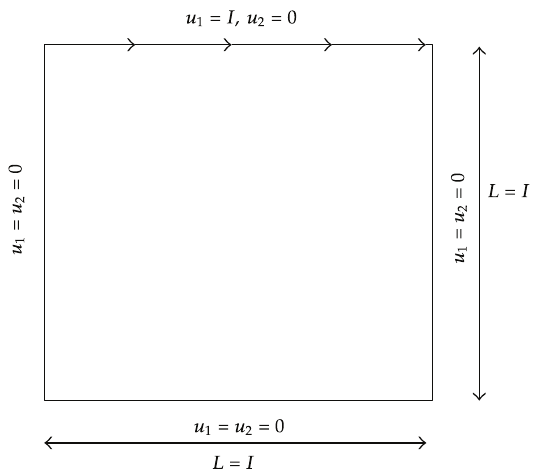
Figure 2: Lid-driven cavity flow.